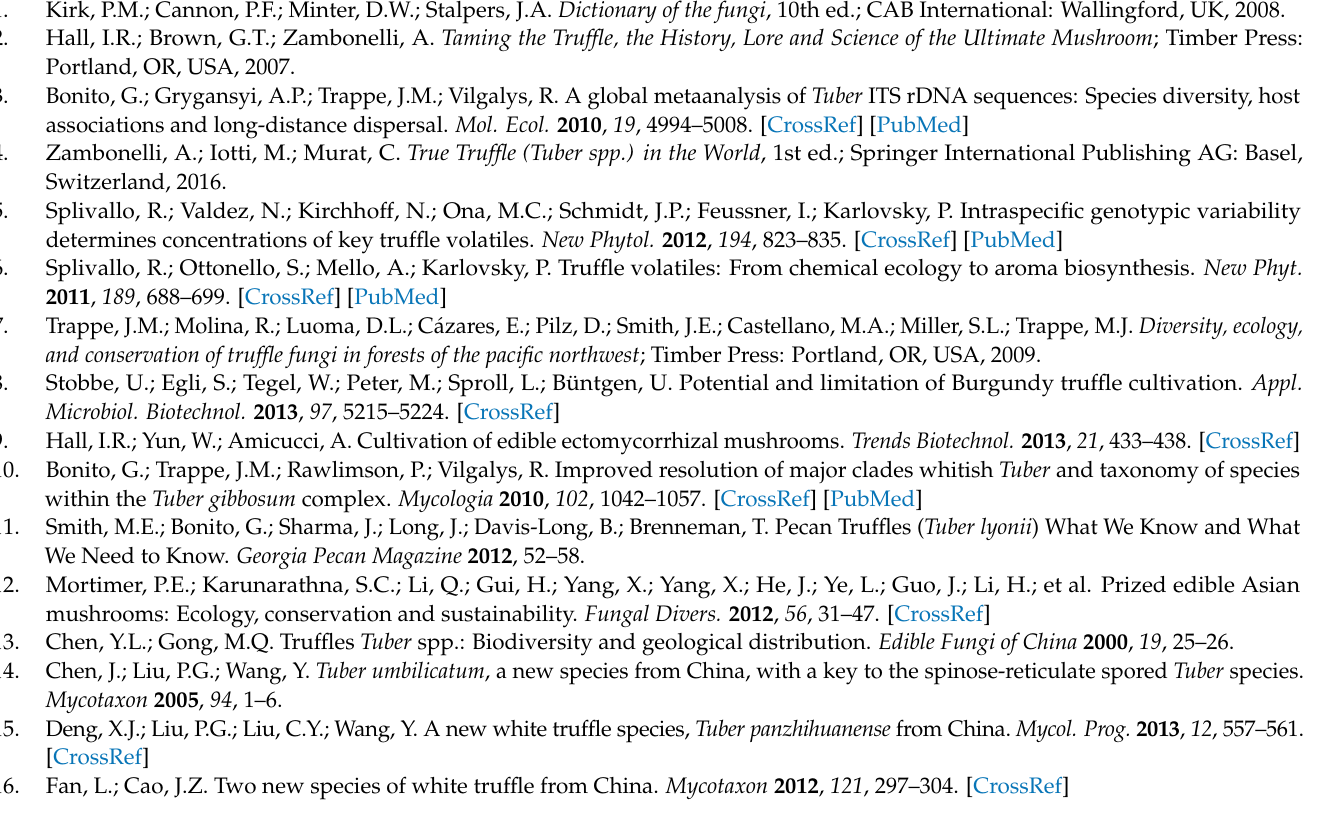
Table S4: The fungal taxonomic assignments in this